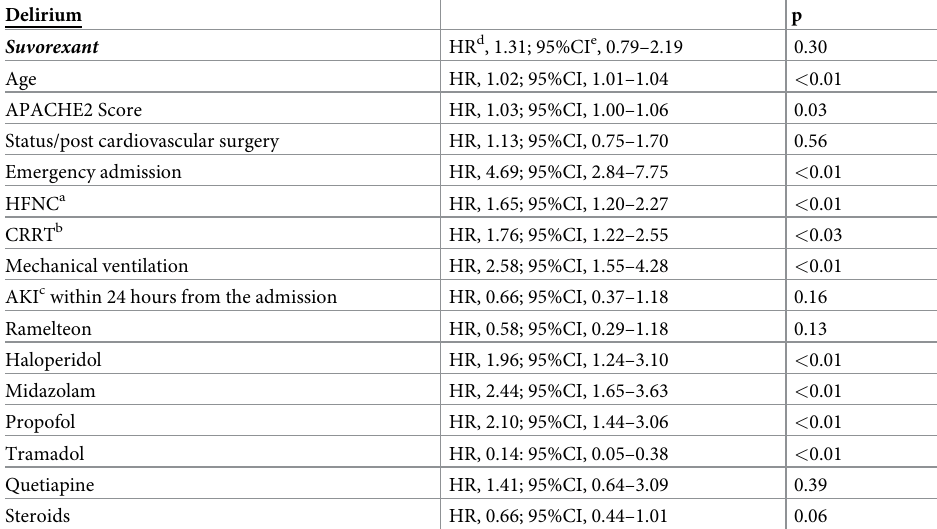
Table 4. Effect of suvorexant on delirium adjusted by